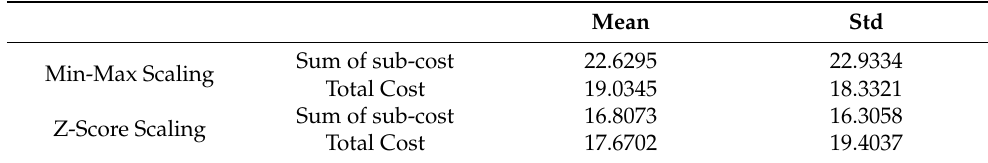
Table 7. Error Rate of cost estimation.